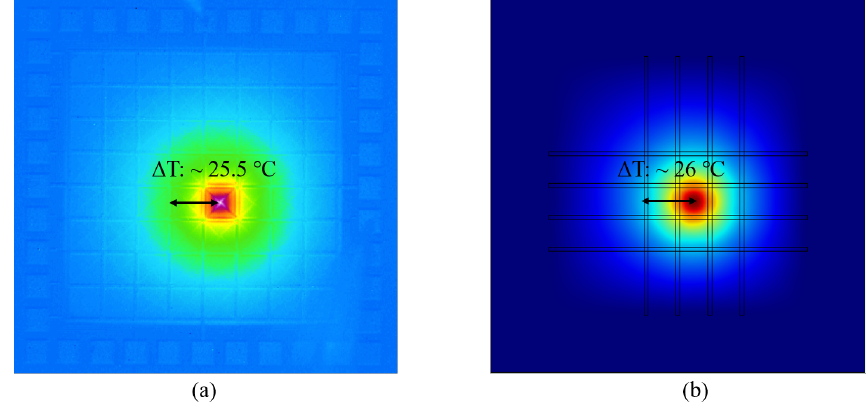
Figure 5. ( a ) Infrared image of the thermopile detector array chip measured using an IR thermal microscope. ( b ) Temperature distribution across the chip obtained from the simulations.